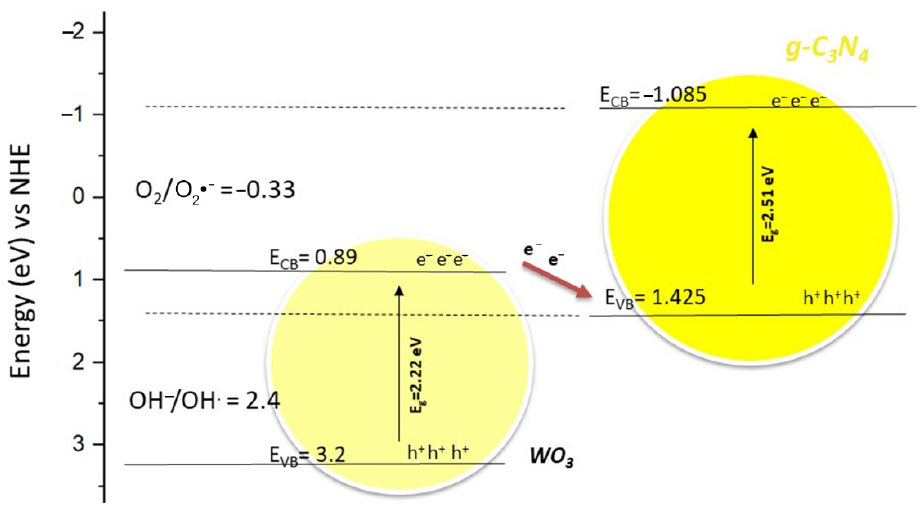
Figure 9. Proposed Z-scheme photocatalytic mechanism for the composite materials.